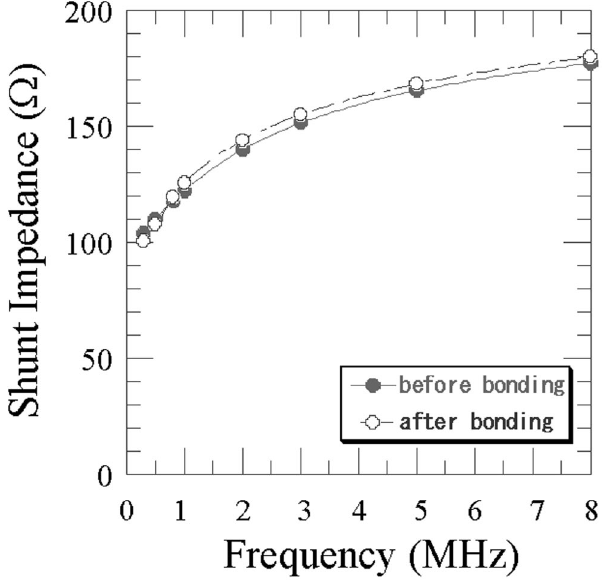
FIG. 6. Shunt impedance of the core before (solid circles) and after (open circles) indium